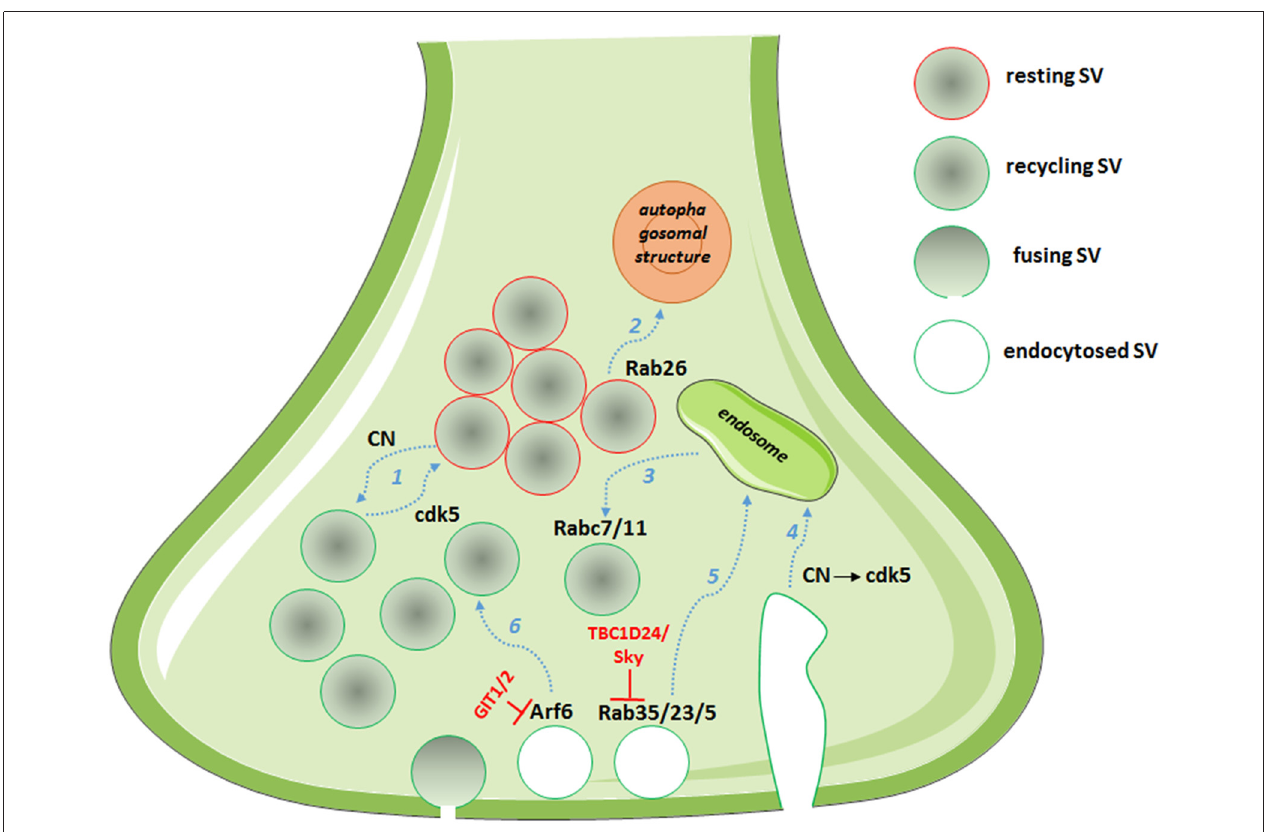
FIGURE 1 | Picture showing the multiple roles of cyclin-dependent kinase 5 (cdk5)/calcineurin (CN) and Rab/ADP-ribosylation factor (Arf) system in defining the route for endocytosed SVs. Dashed arrows in light blue represent synaptic vesicle (SV) routes: (1) partitioning into pools; (2) degradation; (3) post-endosomal trafficking; (4) endosomal sorting after bulk endocytosis; (5) endosomal trafficking; and (6) direct recycling. In red, the GTPase activating proteins (GAPs) with the described functions in controlling the SV